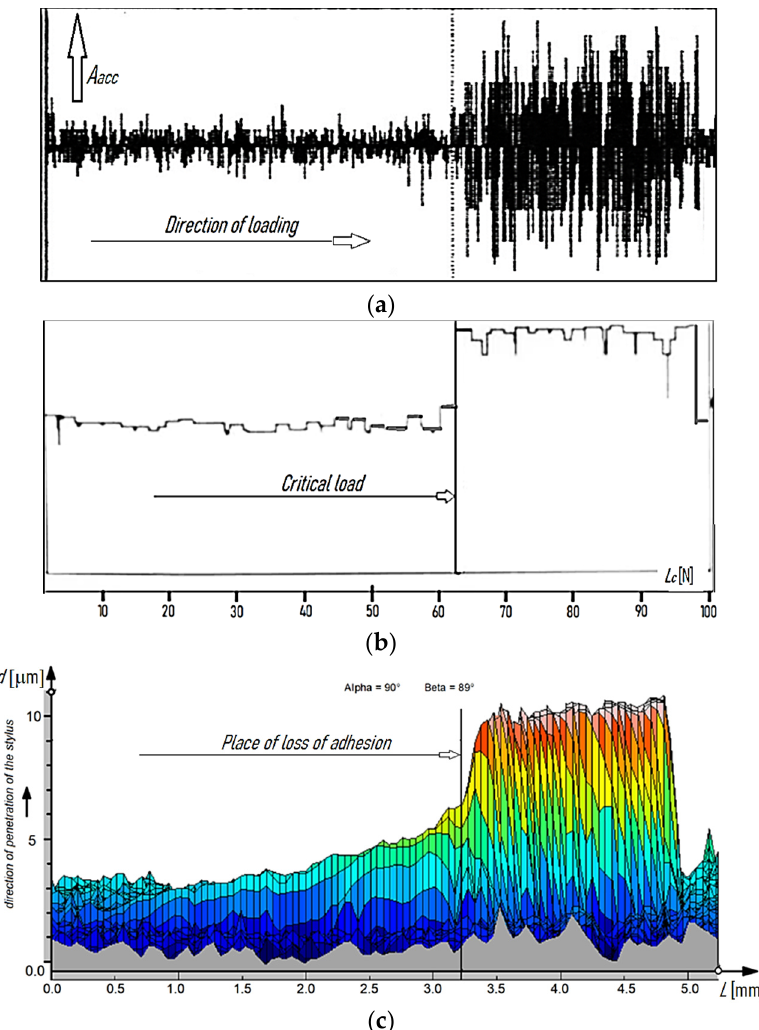
Figure 3. Examples of scratch test results obtained for the TiN coating applied to the cemented car- bide cutting inserts SM25 (P15–P40, M25–M35) before laser heating: ( a ) actual value of the vibration signal (vibration acceleration signal amplitude— A acc ), ( b ) positive envelope of the vibration signal as a function of loading, and ( c ) negative image of the scratch occurring with a gradual increase in the load on the indenter.